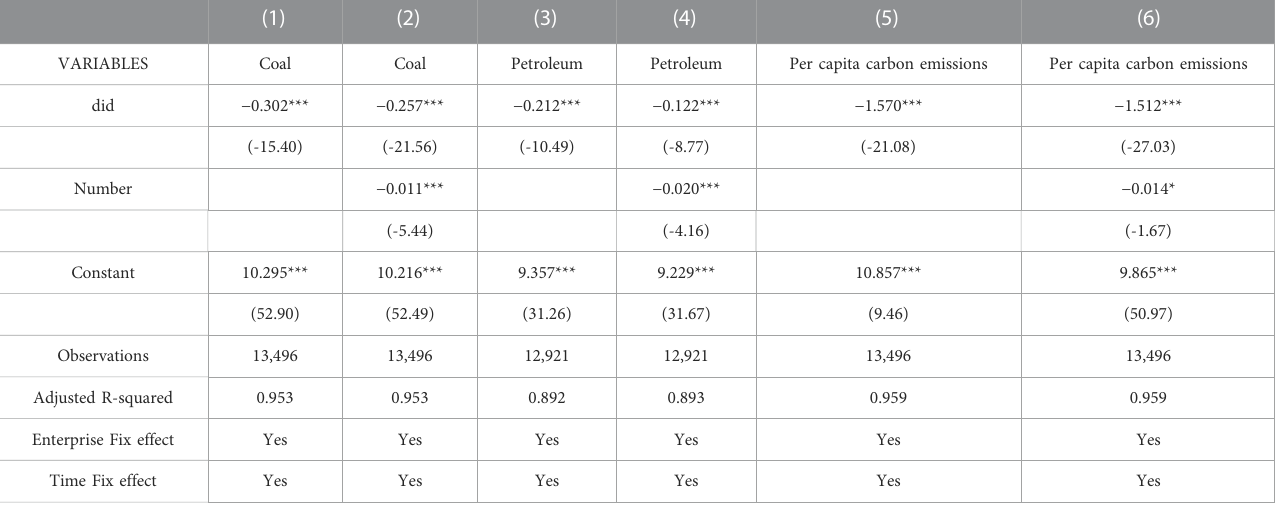
TABLE 8 Impact of carbon transfer on regional carbon